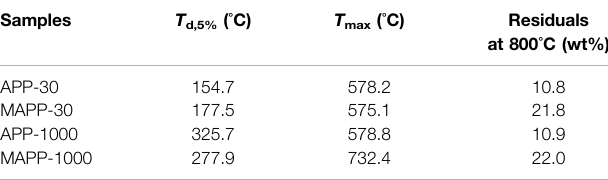
TABLE 2 | TGA Data of APP-30, MAPP-30, APP-1000, and MAPP-1000. Samples